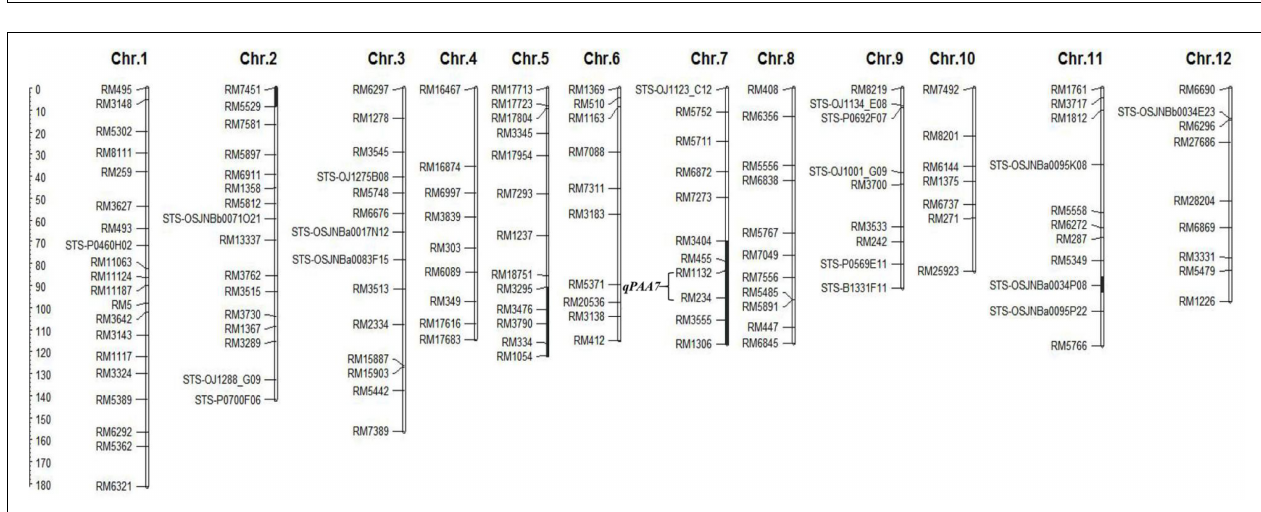
FIGURE 2 | Linkage map of CSSL176. The black bars represent the Koshihikari chromosomal segments in CSSL176. The scale of the ruler indicates the genetic distance, the unit “cM”.